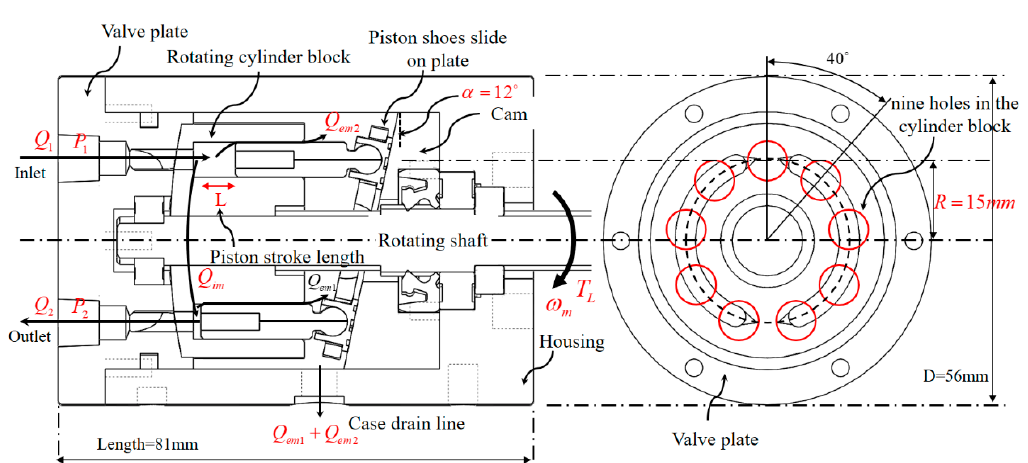
Figure 5. Structure of an axial piston pump. The pump consists of a drive shaft, a valve plate, a cylinder block, pistons, piston shoes, and a swash plate.